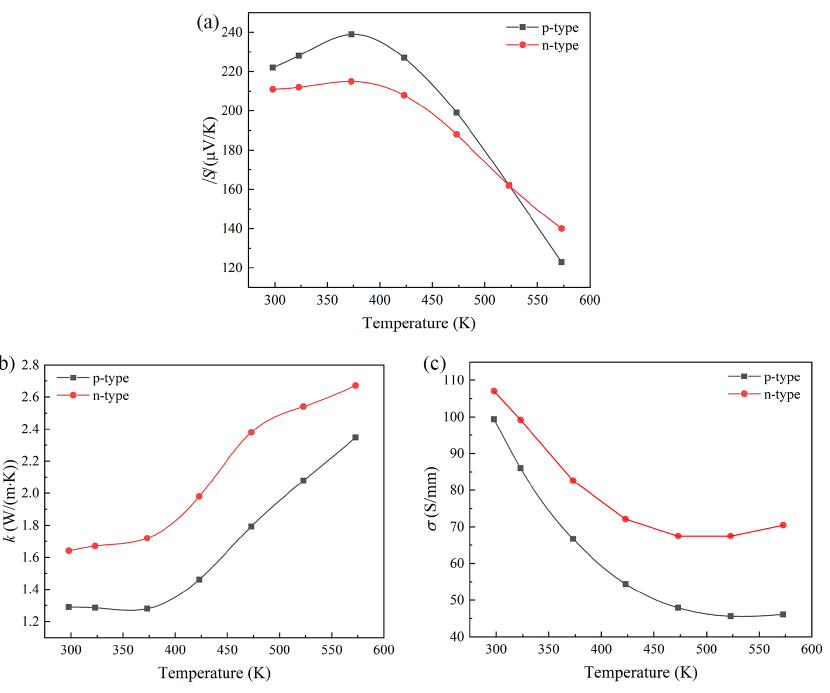
Figure 1. Material parameters at different temperatures: ( a ) Seebeck coefficient, ( b ) thermal conduc- tivity, ( c ) electrical